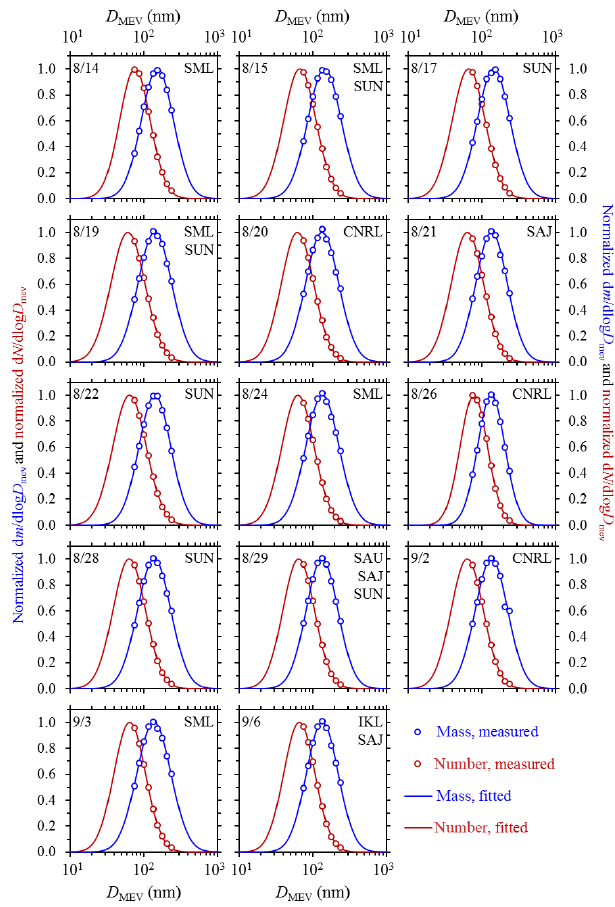
Figure 3. Mass and number size distributions of rBC for the 14 emission flights conducted over the OS facilities. For each flight, measured masses of individual rBC cores are first grouped into dif- ferent size bins and then fitted by a lognormal curve; rBC counts are processed similarly. Results from flight tracks between the air- port and OS facilities are not involved in the analysis. Measurement dates and the targeted OS facilities (1–3) are also shown for each flight. MMD, NMD, mass and number distribution widths, which are determined by lognormal fits to the measurement results, are summarized in Supplement Table S1 for these emission